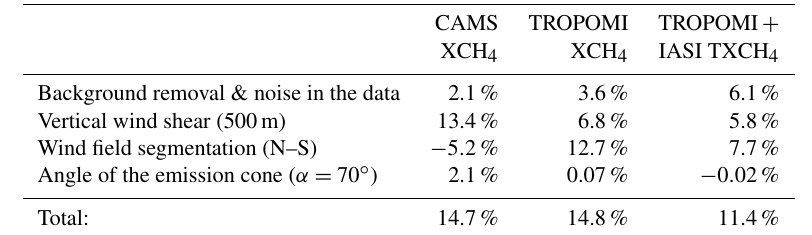
Table A2. Changes in the estimated emission rates for different products when using different input data or under different situations compared to their results using the default setting (wind at 330m, NE–SW wind segmentation, α = 60 ◦ , CAMS-GLOB-ANT for CAMS